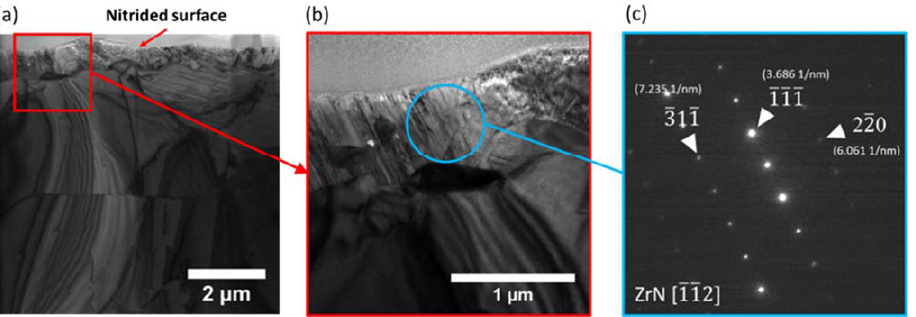
Figure 3. Raman spectra of Zircaloy-4 nitrided at 600, 700, and 800 °C.